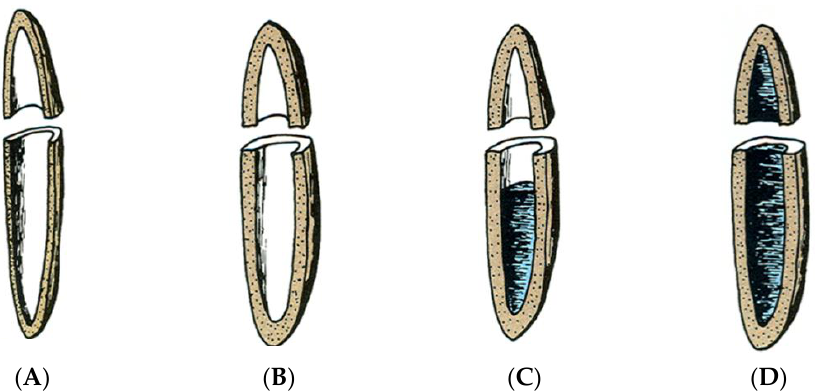
Figure 2. Dry surface fiber ( A ), fiber saturated with moisture (FSP) ( B ), fiber filling with liquid water ( C ), fully saturated fiber ( D ).